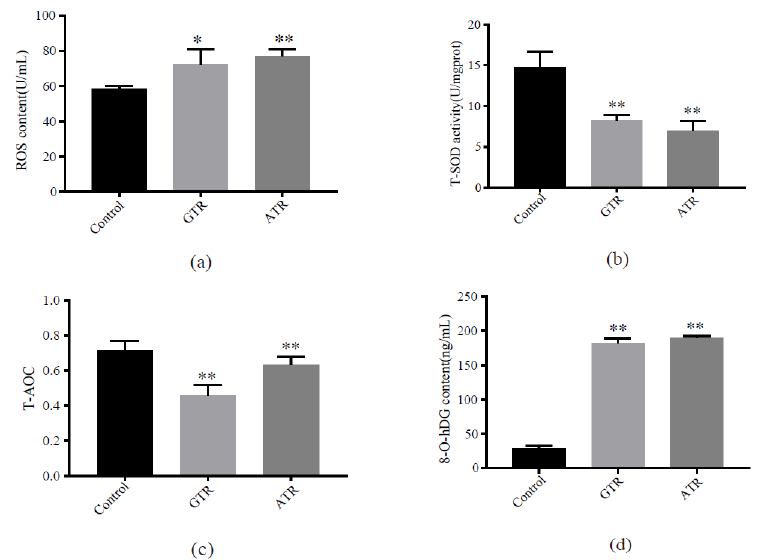
Figure 2. Effect of heat stress on antioxidant system and DNA damage product in the gills of Japa- nese flounder under two kinds of heat stress. Subfigure ( a – d ) represents ROS content, T-SOD activ-